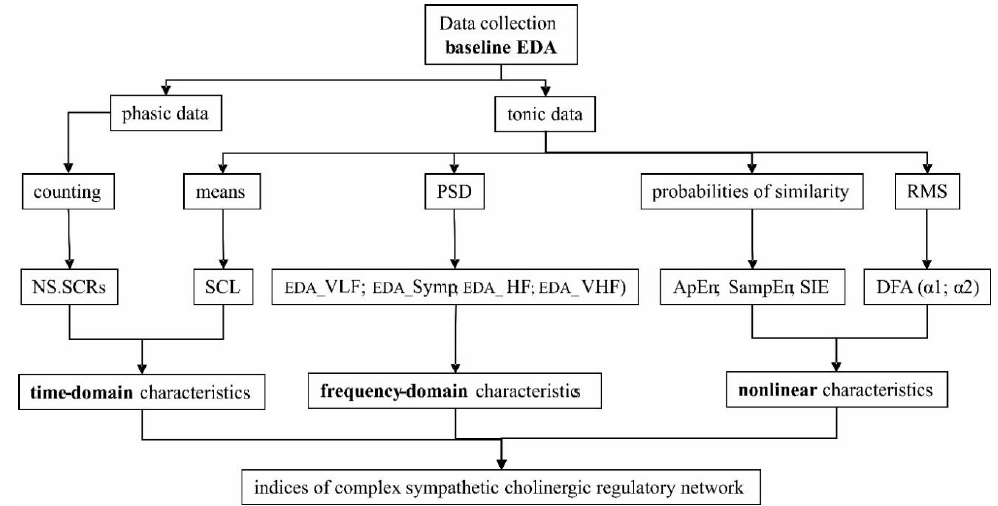
Figure 1. Evaluation of electrodermal activity (EDA) parameters. SCL—skin conductance level; NS.SCRs—nonspecific skin conductance responses; PSD—power spectral density; EDA-VLF—electrodermal activity in very low frequency band; EDA-Symp—EDA in the sum of low and high 1 frequency bands; EDA-HF—EDA in high 2 frequency band; EDA-VHF—EDA in very high frequency band; ApEn—approximate entropy; SampEn—sample entropy; SIE—symbolic information entropy; RMS—rootmeansquare; DFA—detrendedfluctuationanalysis; α 1, α 2—indicesofdetrendedfluctuation